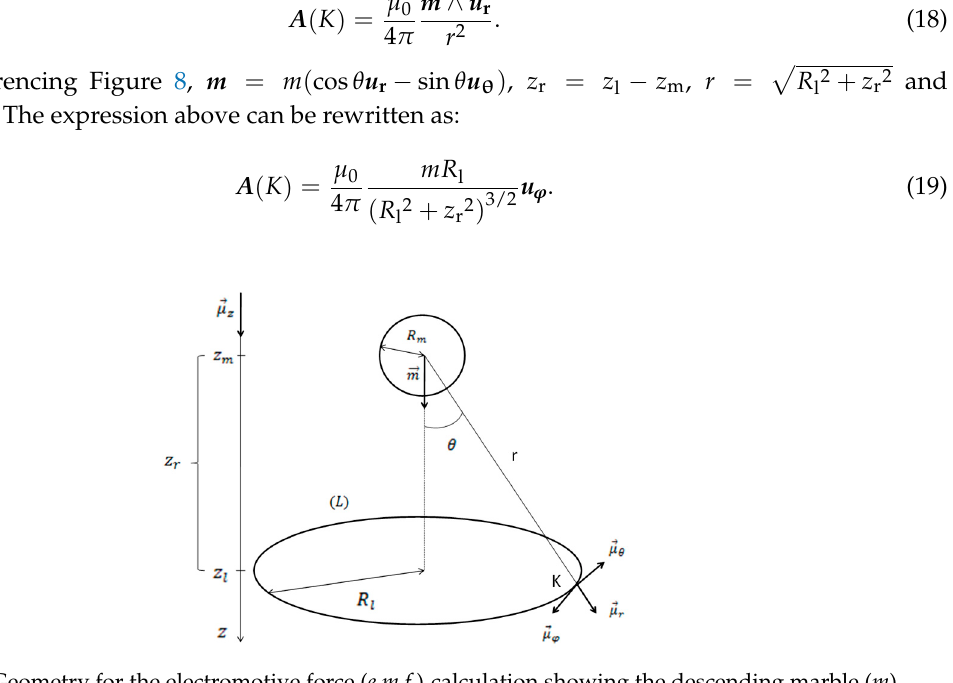
Figure 8. Geometry for the electromotive force ( e.m.f. ) calculation showing the descending marble ( m ) above the loop ( L ).